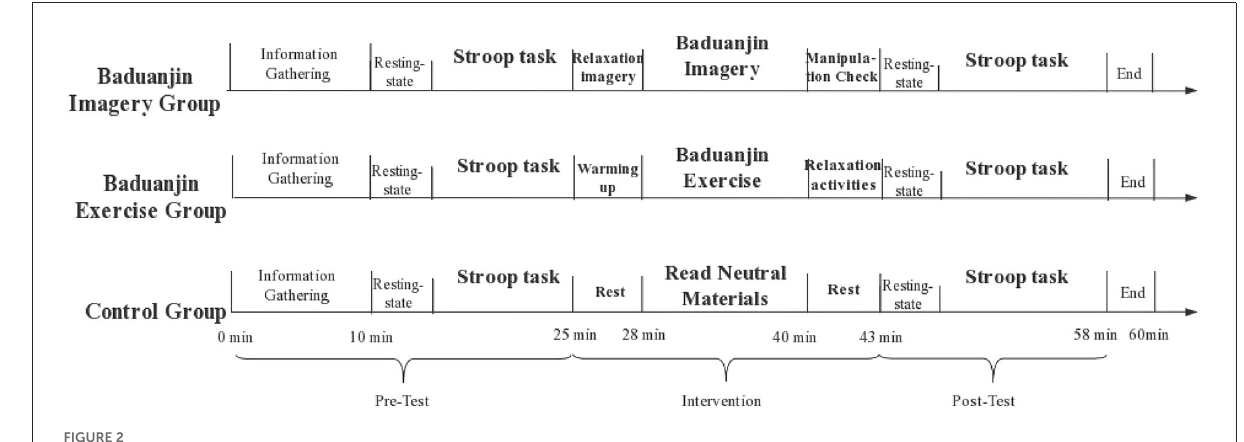
FIGURE2 Chart of the experimental